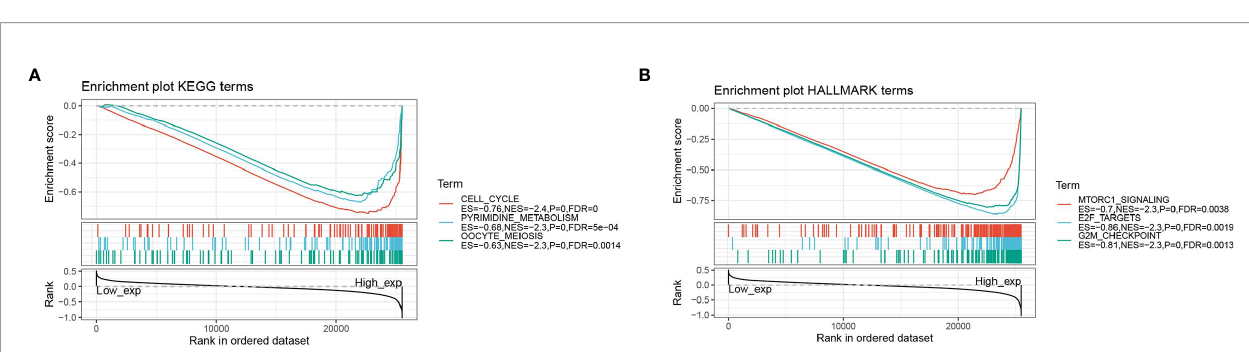
FIGURE 8 | GSEA analysis of ASF1B; (A) enrichment analysis of ASF1B in KEGG signaling pathway; (B) enrichment analysis of ASF1B in HALLMARK signaling